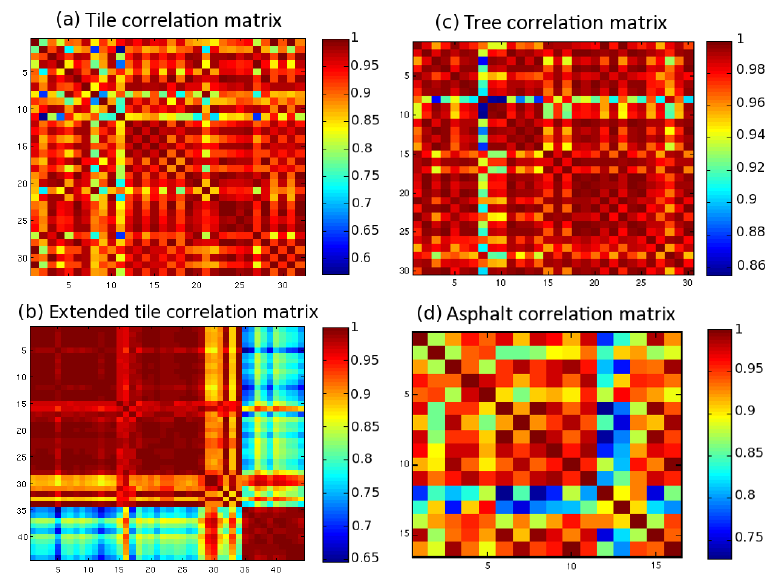
Figure 3. Pixel-to-pixel correlation matrices of the four classes or subclasses, showing the intra-class variability: ( a ) tiles: 32 spectra from the same roof; ( b ) tiles: 44 spectra from several roofs; ( c ) plane trees: 30 spectra; ( d ) avenue asphalt: 16 spectra.